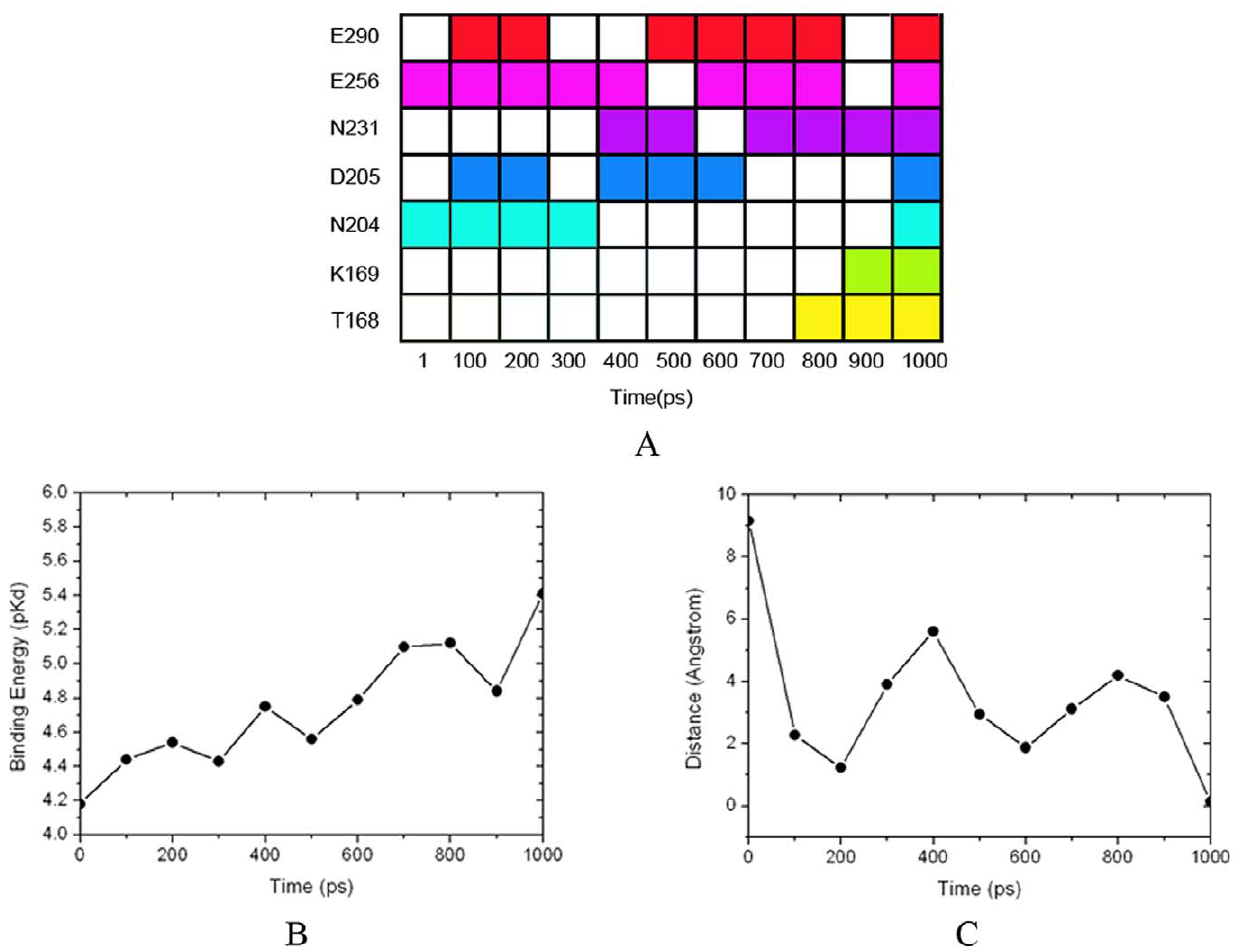
Figure 8. Process of glucose binding to GK. (A) The residues of GK in contact with glucose during the TMD simulation, represented by different colors. The colored frame means glucose has contact with the residue, while the blank frame means glucose does not have contact with the residue. (B) Binding affinity between glucose and GK calculated by X-Score. (C) wRMSD of the heavy atoms between the crystal pose and docked pose of